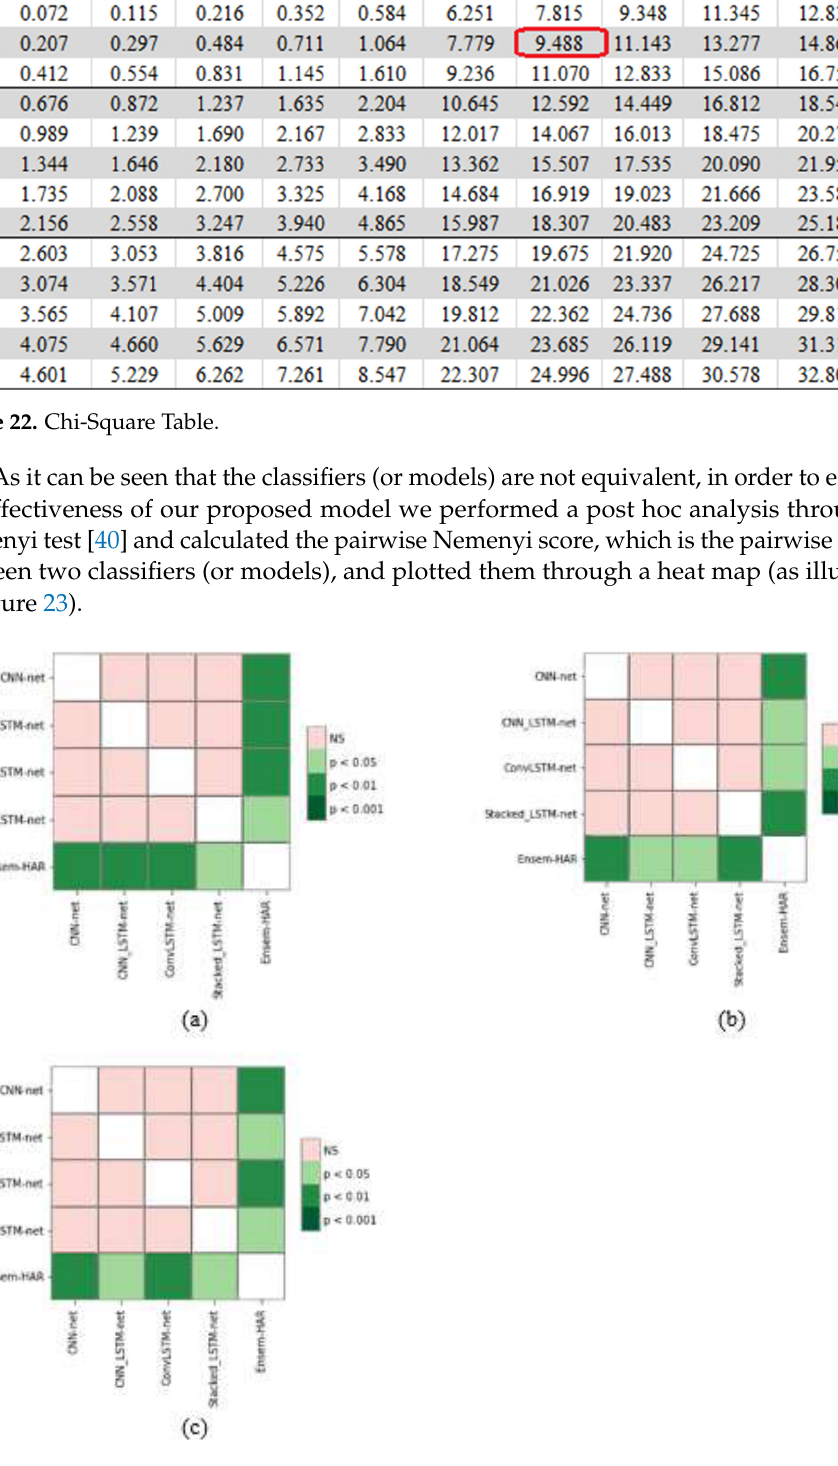
Figure 23. Pairwise Nemenyi score plot generated for: ( a ) WISDM; ( b ) PAMAP2; and ( c ) UCI-HAR datasets.